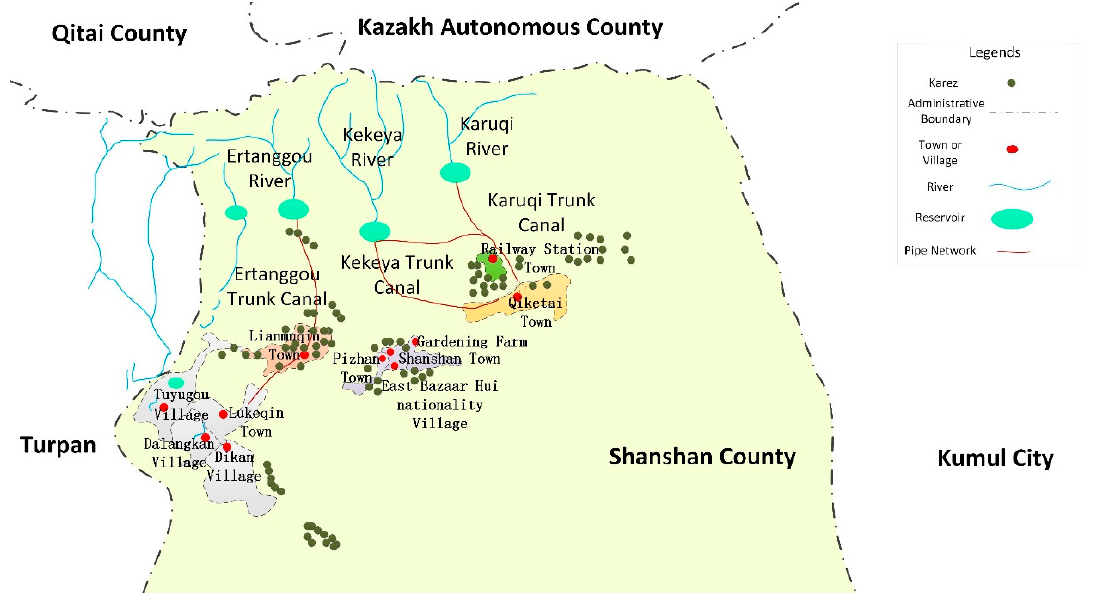
Figure 3. Distribution of Karez projects in Shanshan County.